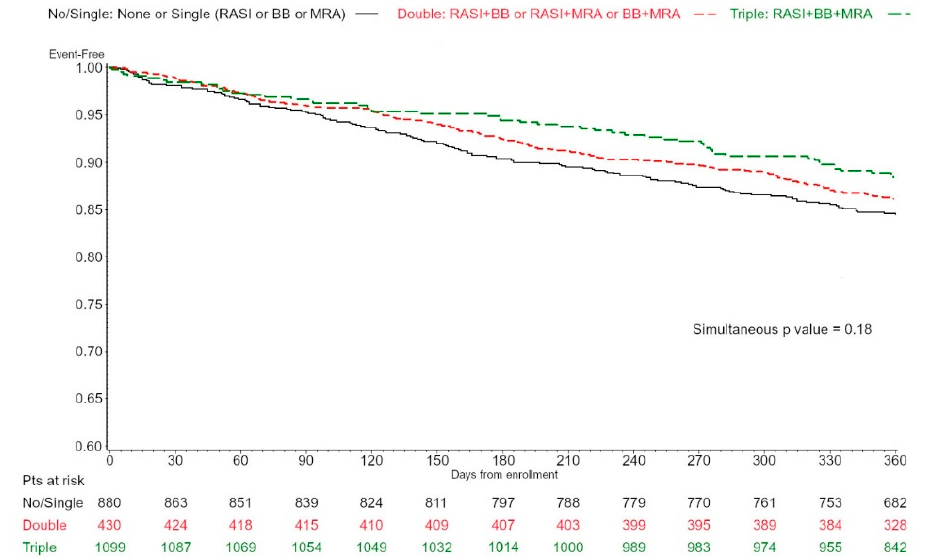
Figure 2. Age-adjusted Kaplan–Meier curves on all-cause mortality or cardiovascular hospitalization according to conventional NHM (RASI, betablockers, and MRA), none/single vs. double vs. triple, in 2409 patients with HFpEF after adjustment by age categories. NHM, neurohumoral modulation.